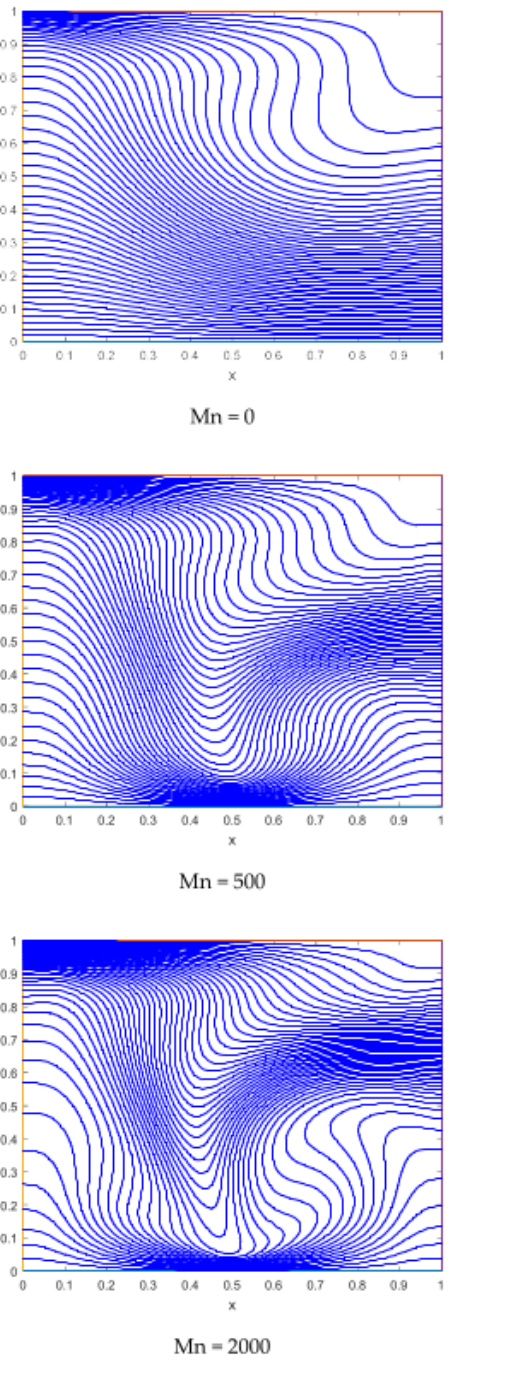
Figure 8. Representation of isotherms for different values of the magnetic interaction